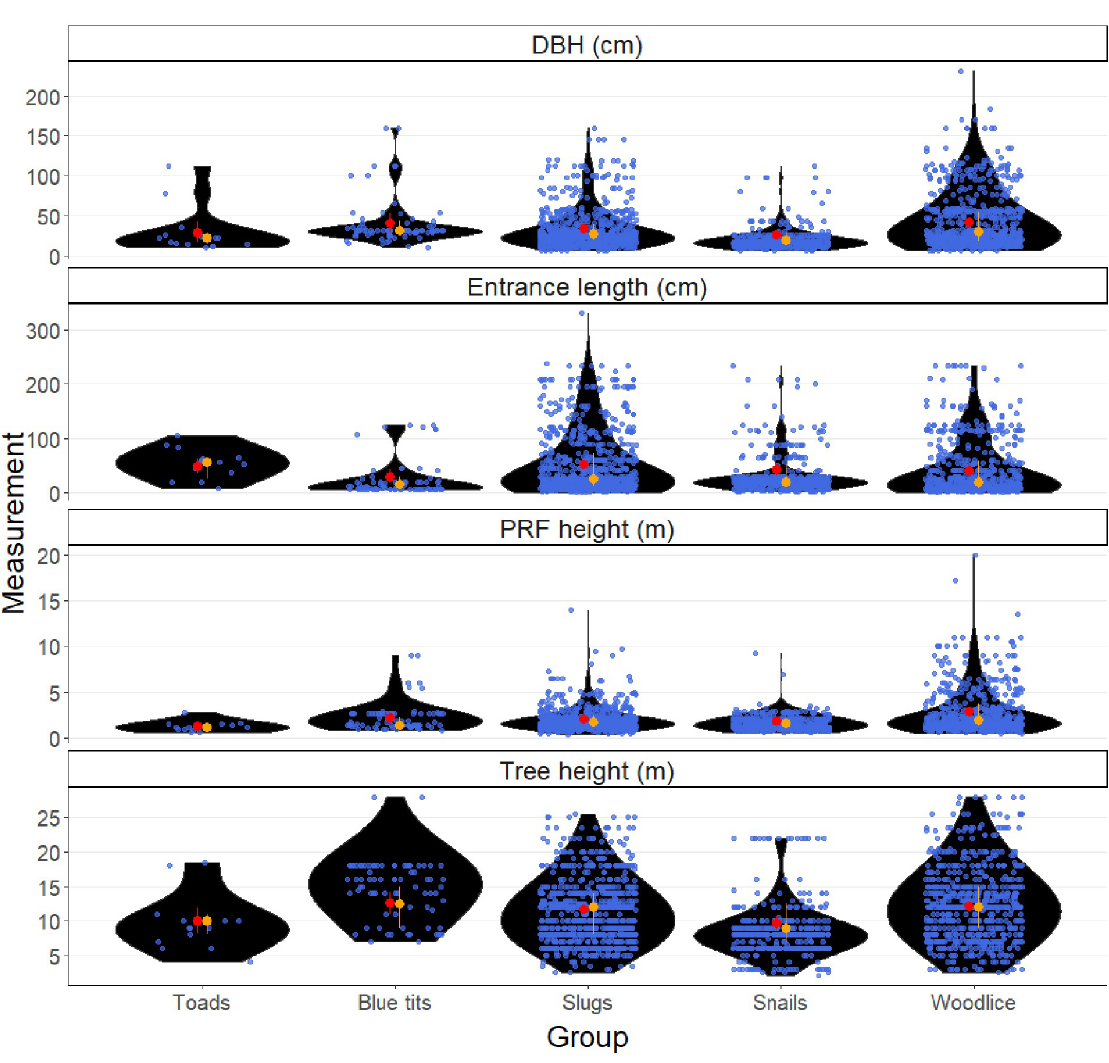
Fig 3. Comparative tree characteristics for multiple taxa recorded in tree cavities (PRFs) as part of the BTHK survey showing raw mean values plus 95% confidence intervals in red; median plus upper and lower quantiles in orange. To aid data visualisation, we have excluded four datapoints for PRF height greater than or equal to 13.5m (3 for woodlice and 1 for